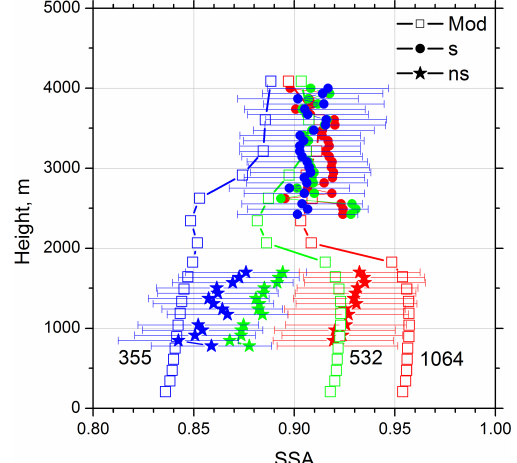
Figure 19. The single scattering albedo at 355nm (blue), 532nm (green), and 1064nm (red) on 24 December 2015 retrieved from 3 β + 2 α lidar measurements shown in Fig. 7a (solid symbols) and provided by the MERRA-2 model for 21:00UTC (line + open symbols). For inversion of lidar data the spheroids (ns) were used below 2000m and spheres (s) above